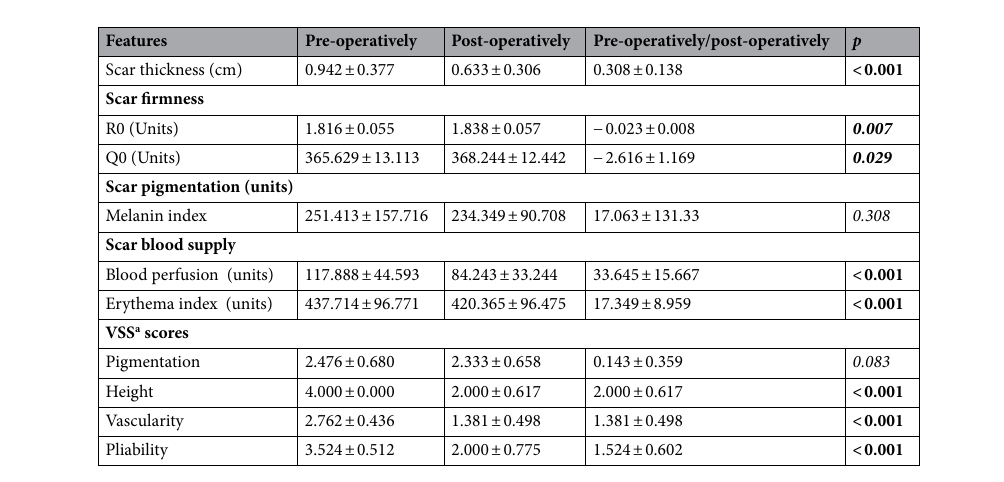
Table 2. Scar modifications, pre and post laser treatment. a Vancouver scar